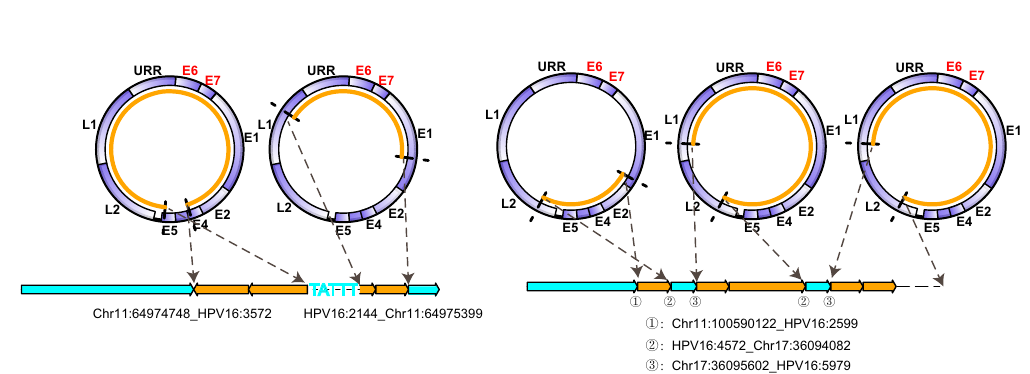
Fig. 2 Four types of integrated HPV DNA segments in clonal integration events. a Type A, a truncated HPV genome containing E6/E7. b Type B, a truncated HPV genome lacking E6/E7. c Type C, an over fl owing continuous segment containing the intact HPV genome. d Type D, a combination of Type A, Type B, or Type C. In each panel, the two dashed arrows on the top indicate the HPV DNA fragment that was integrated into the human genome; the light blue and orange boxes on the bottom represent the human genome and virus genome, respectively. Source data are provided as a Source Data fi